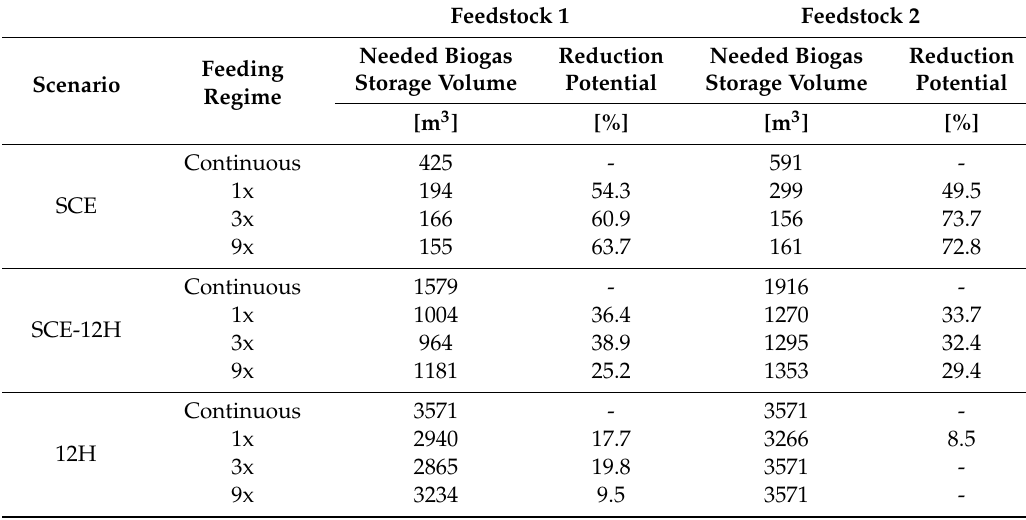
Table 6. The reduction potential of needed biogas storage capacity for investigated power generation scenarios and feeding